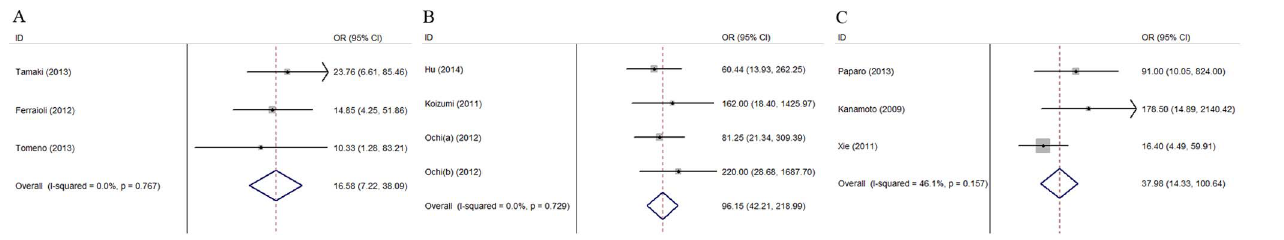
Fig. 3. Forest plot from meta-analysis of DOR value using a random-effect or fixed-effect model for significant fibrosis. (A) Forest plot of LFI and (B) Forest plot of ER1 and (C) Forest plot of ER2. DOR: diagnostic odds ratio; LFI: liver fibrosis index; ER1: the elastic ratio of the liver for the intrahepatic vein; ER2: the elastic ratio of the liver for the intercostal muscle; Ochi (a): the training set of the subjects in the study by Ochi et al; Ochi (b): the validating set of the subjects in the study by Ochi et al.